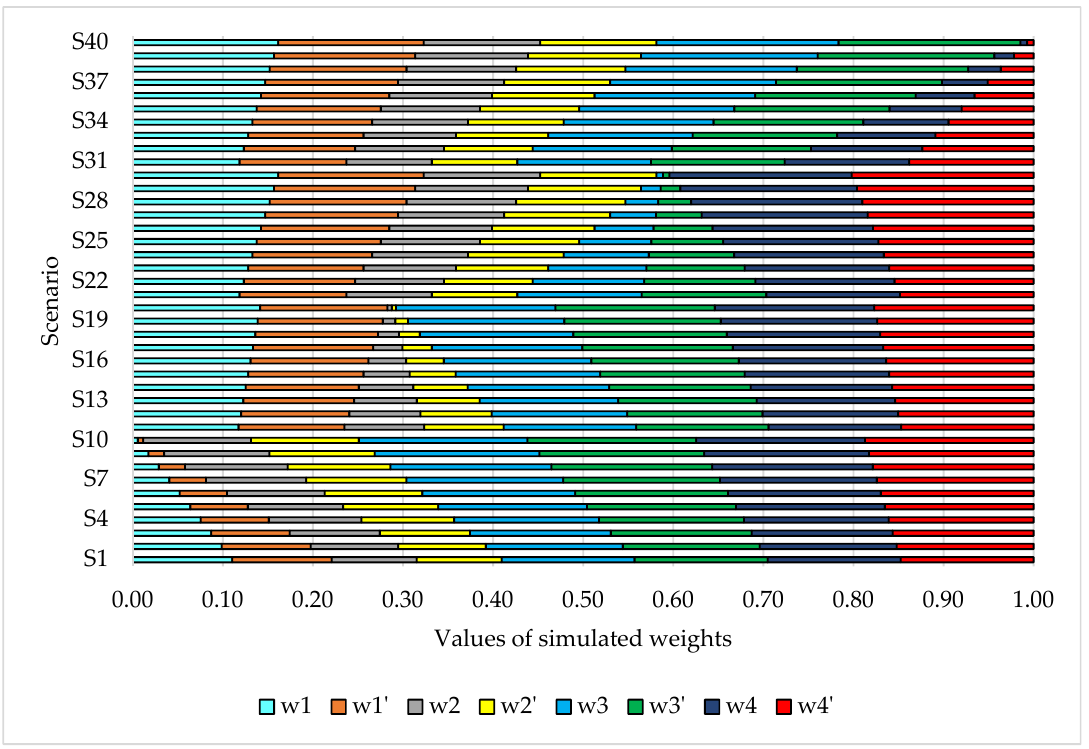
Figure 3. Simulation of the weight values of criteria through 40 newly formed scenarios.